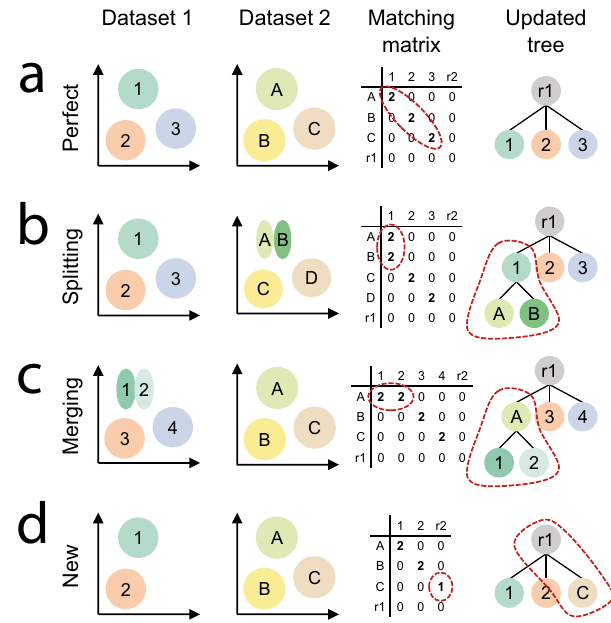
Fig. 2 Schematic examples of different matching scenarios. a Perfect match, b splitting, c merging, and d new population. The fi rst two columns represent a schematic representation of two datasets. After cross- predictions, the matching matrix ( X ) is constructed using the confusion matrices (Methods). We update the tree based on X . inconsistently labeled and the labels cannot be matched (Sup- plementary Note 1). In this case, one of the populations might be missing from the tree.